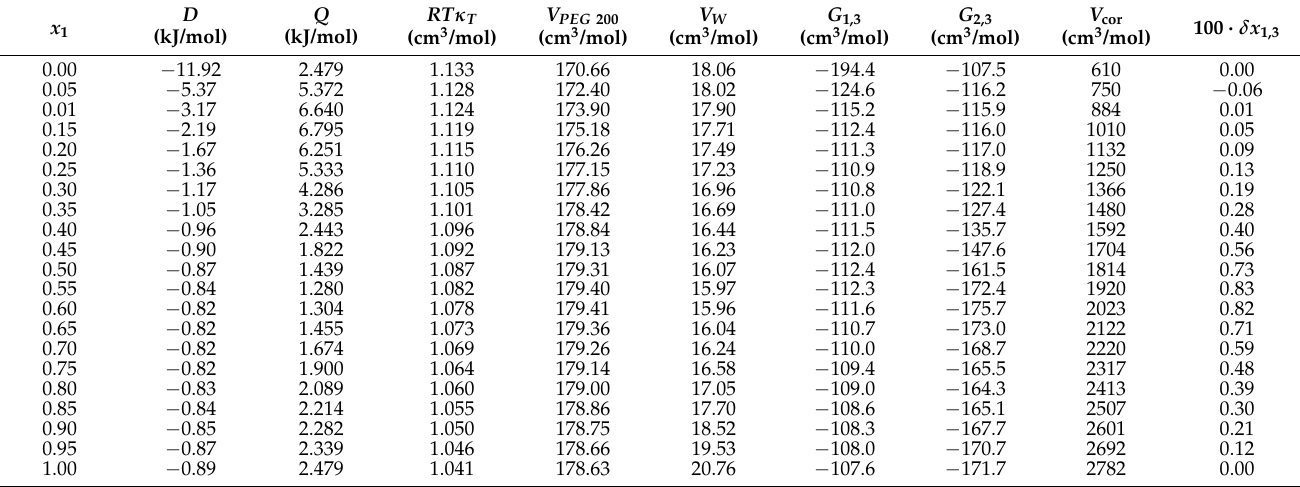
Table 8. Some properties associated to preferential solvation of isoniazid (3) in (PEG 200 (1) + water (2)) cosolvent